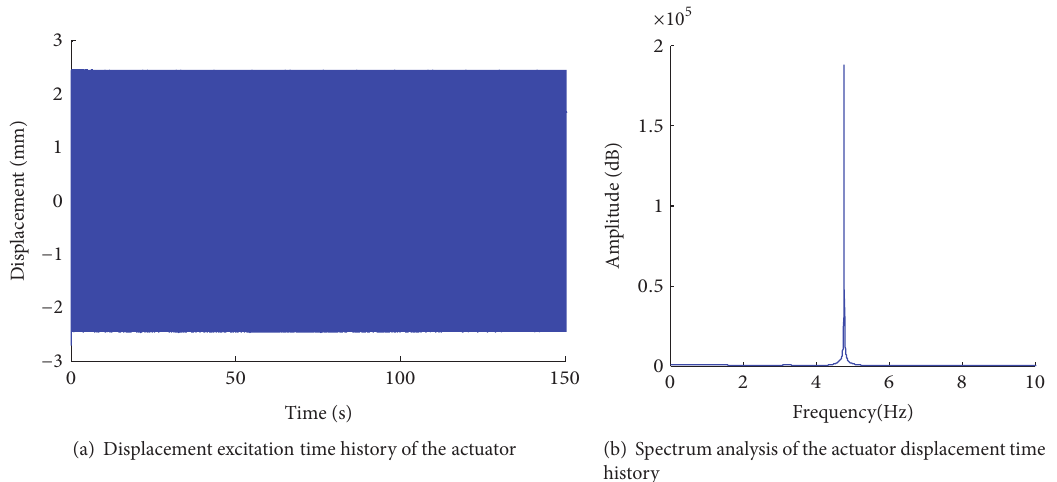
Figure 15: Displacement time history and its amplitude-frequency curve of the actuator.